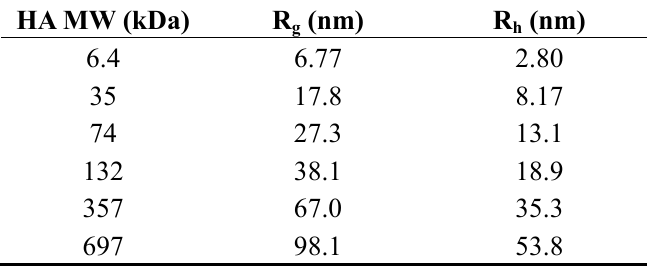
Table 2. Radius of gyration (R equations from Takahashi et al. reported data for each MW of HA used in the in vivo imaging